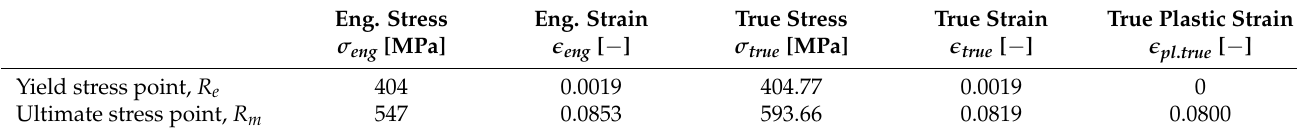
Table 2. Sleeve stress and strain conversions. Eng.